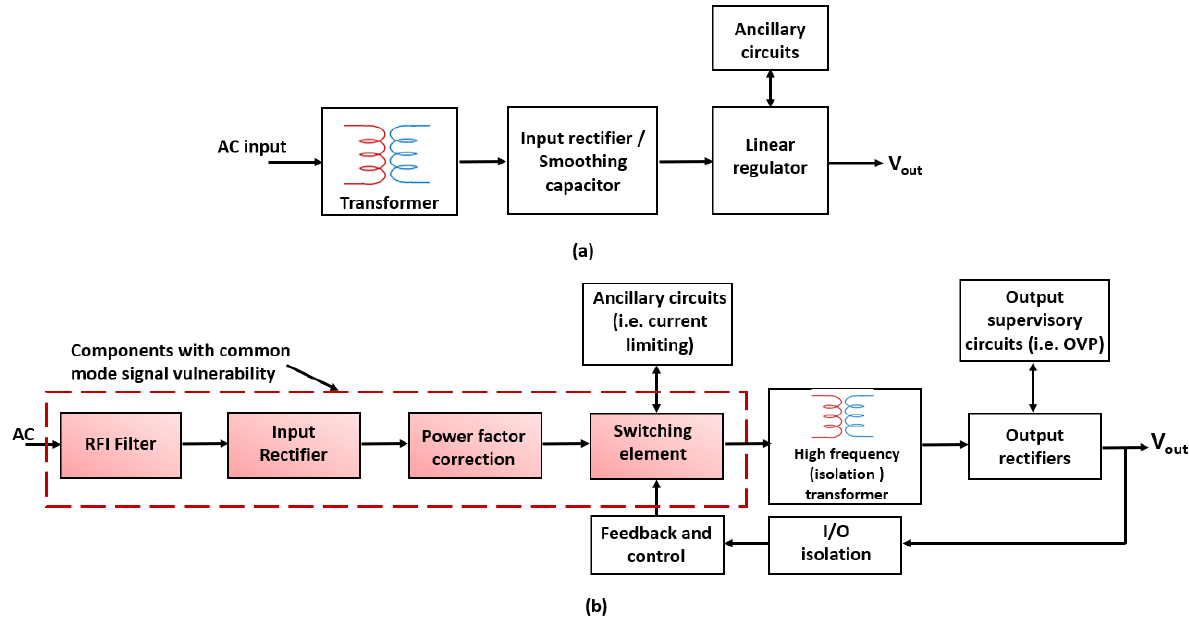
Figure 2. Comparison of linear power supplies and modern SMPS: ( a ) simple linear power supply with an isolation transformer ( b ) modern off-the-line switching power supply and its components vulnerable to power quality issues such as swells, sags, and transient over-voltages.